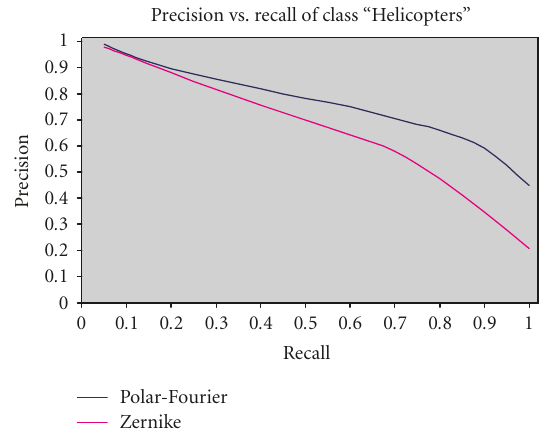
Figure 6: Comparison of the e ffi ciency of the Polar-Fourier-based descriptor vector against the Zernike moments-based descriptor vector for a class of the new